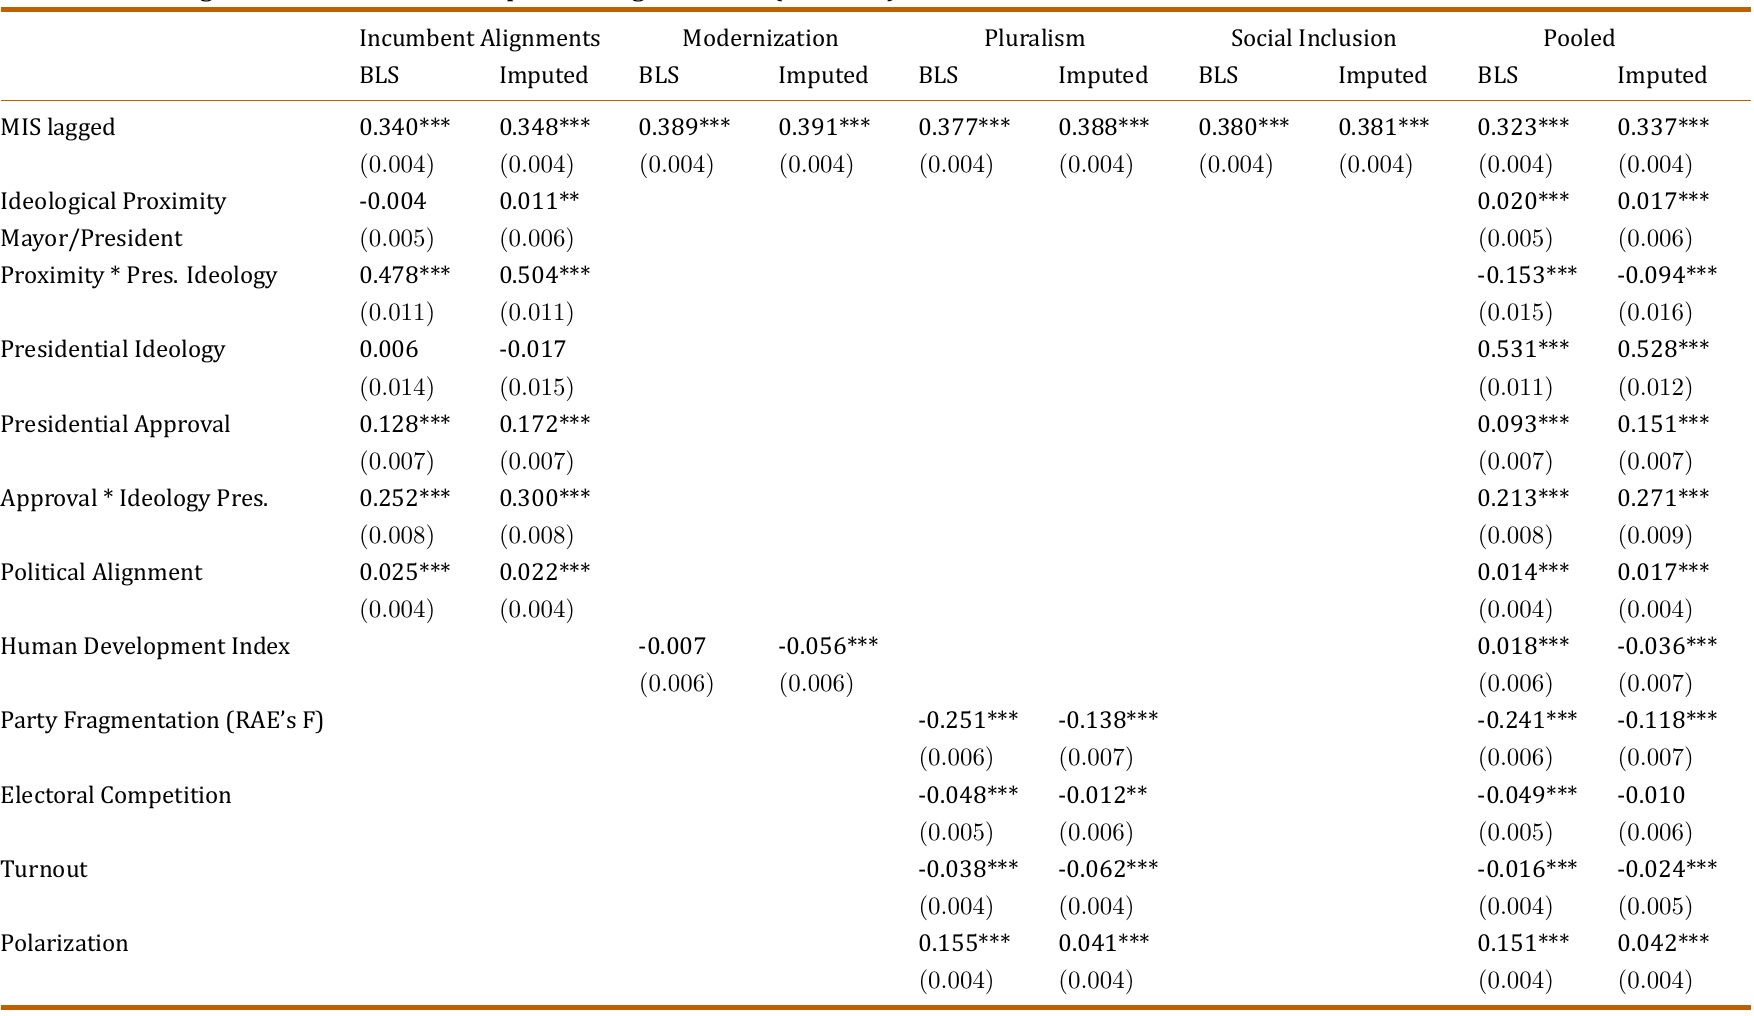
Table 1: GLS regressions for the municipal ideological score